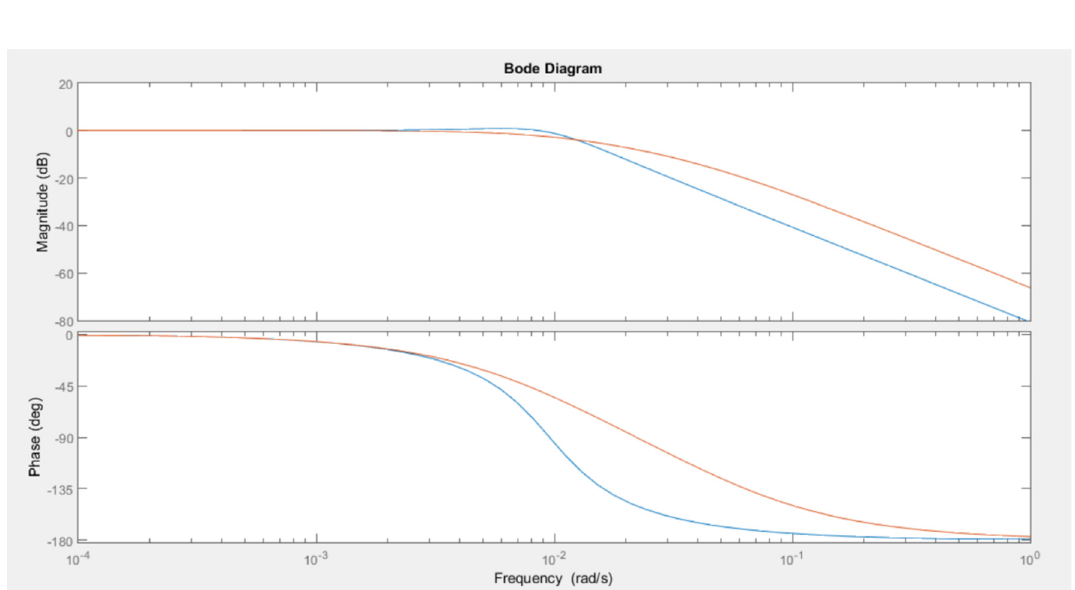
Figure 3. Length = 50 km, diameter = 1 m, mass flow = 120 kg/s, T ∈ (0.5 h;24 h). (c) For L = 50 km, D = 1.0 m, and mass flow = 120 (d) For L = 50 km, D = 1.0 m, and mass flow = 240 kg/s: